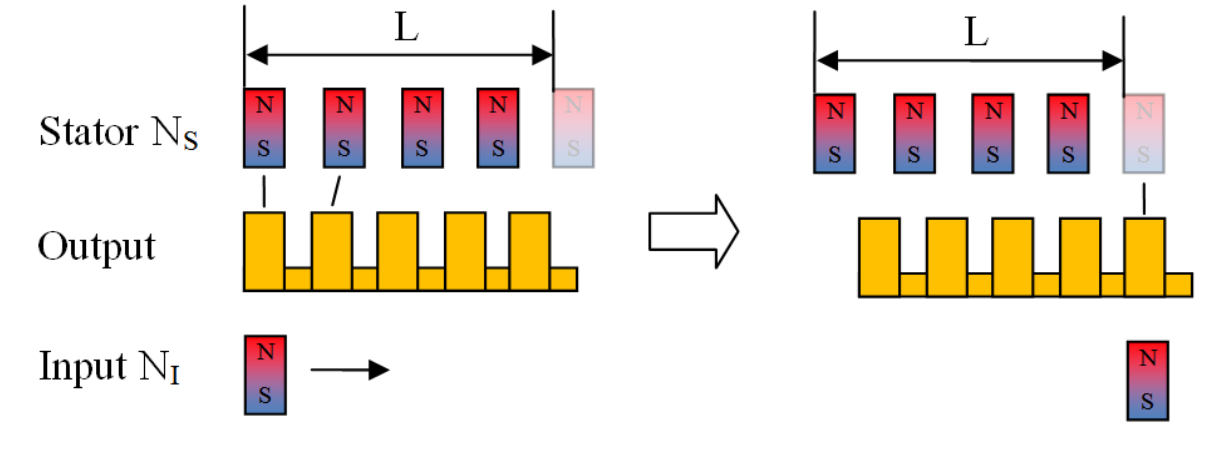
Figure 1. Scheme of the MAGDRIVE mesh